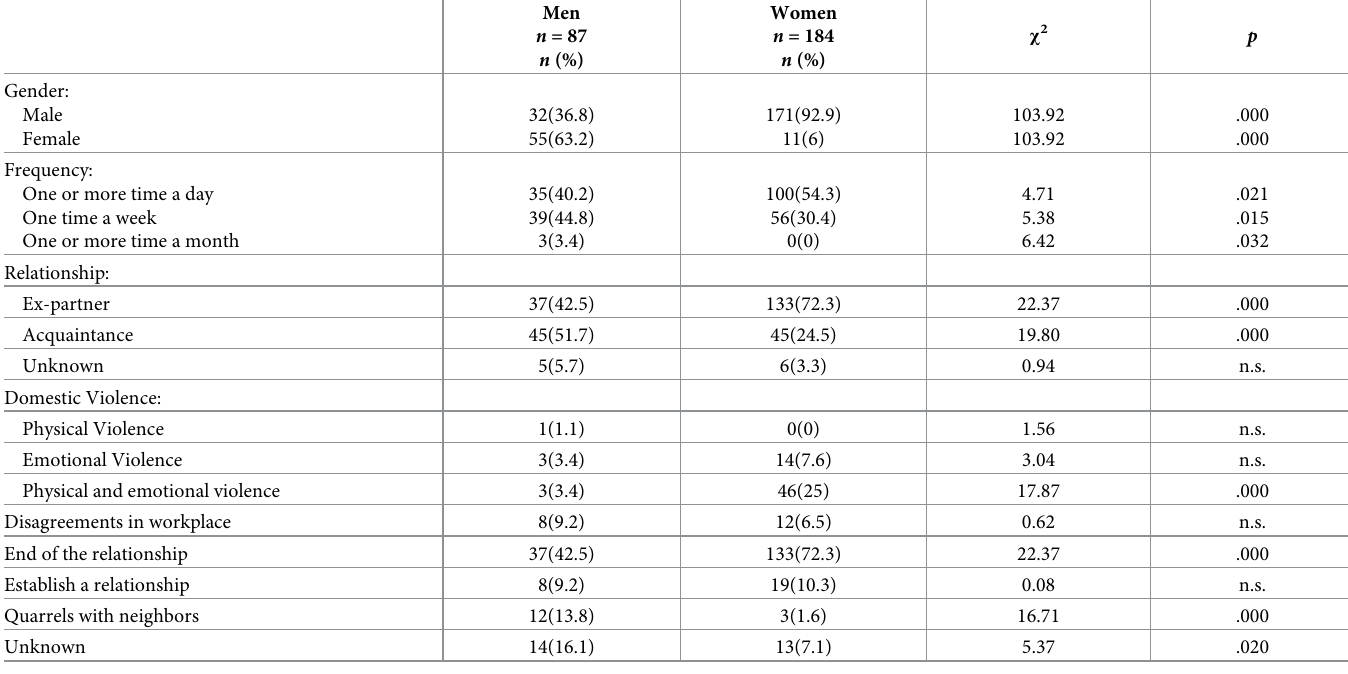
Table 1. Characteristics of the relationship victims-stalker and motive for the beginning of the stalking campaign in men and women that report to police (N =